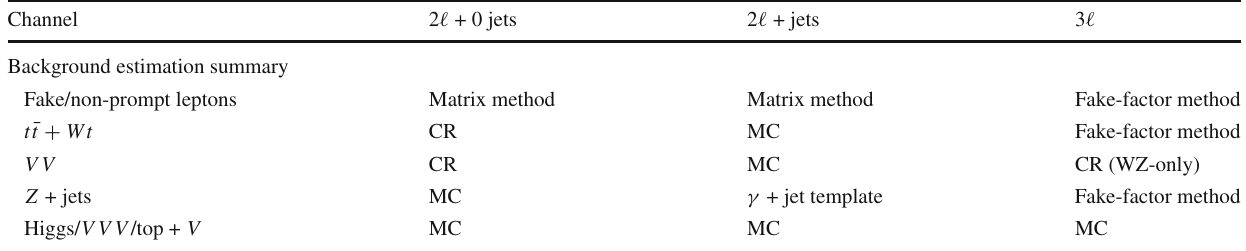
Table 4 Summary of the estimation methods used in each search chan- nel. Backgrounds denoted CR have a dedicated control region that is included in a simultaneous likelihood fit to data to extract a data-driven normalization factor that is used to scale the MC prediction. The γ + jet